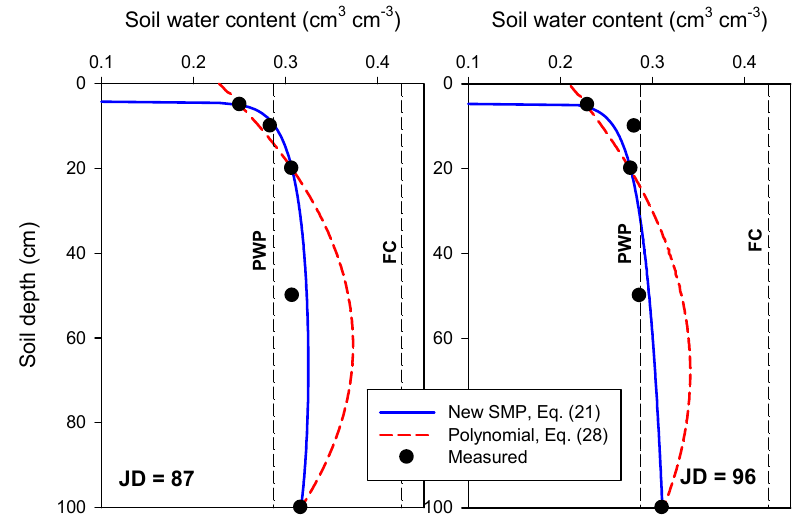
Figure 5. Comparison of Equations (21), new solution, and Equation (28), second order polynomial, with measured soil moisture data from SCAN site number 2078 (Madison, Alabama) at Julian days (JD) 87 and 96, 2012. The clay soil parameters, P = 15.9 and h cM = 350 cm, were used in Equation (21).